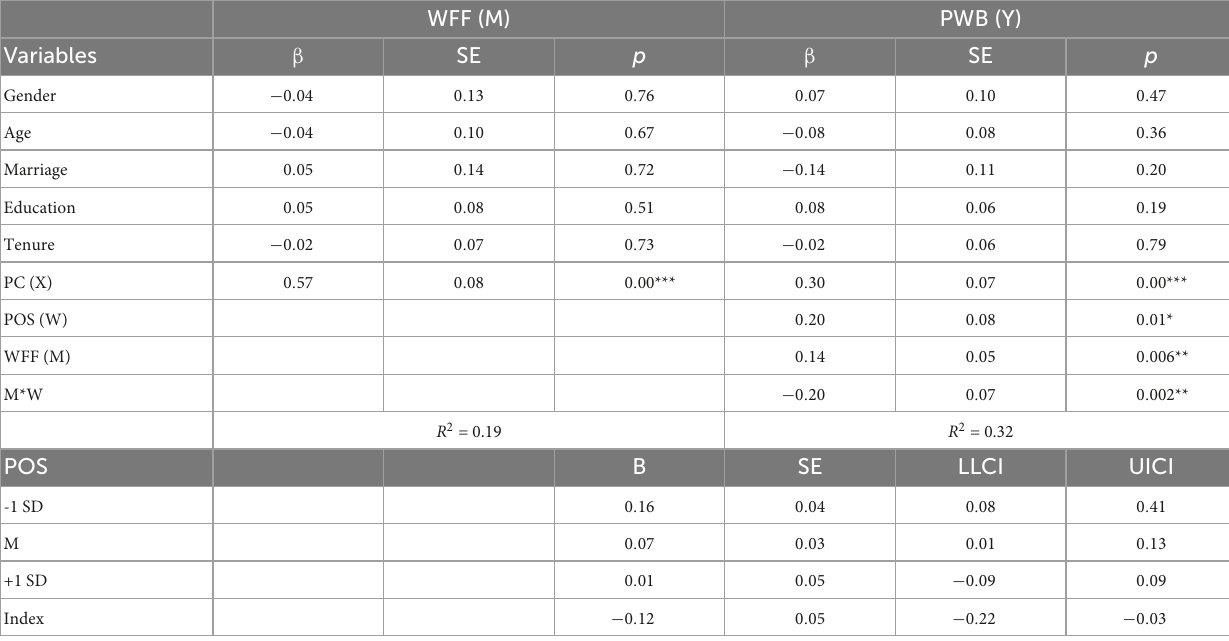
TABLE 7 Results of moderated-mediation of WFF.